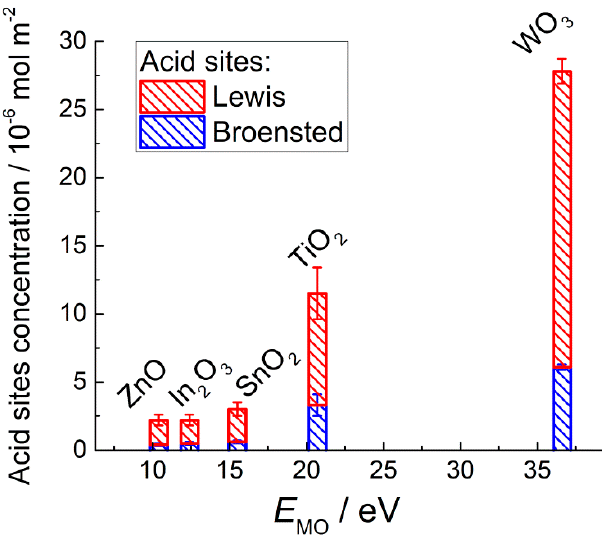
Figure 12. Concentration of Brønsted and Lewis acid sites at the surface of nanocrystalline n-type MOS synthesized at 300 °C (ZnO, In 2 O 3 , SnO 2 , WO 3 ) and 700 °C (TiO 2 ) in relation to metal-oxygen bond energy. Adapted with permission from reference [78]. Copyright 2021 Elsevier.